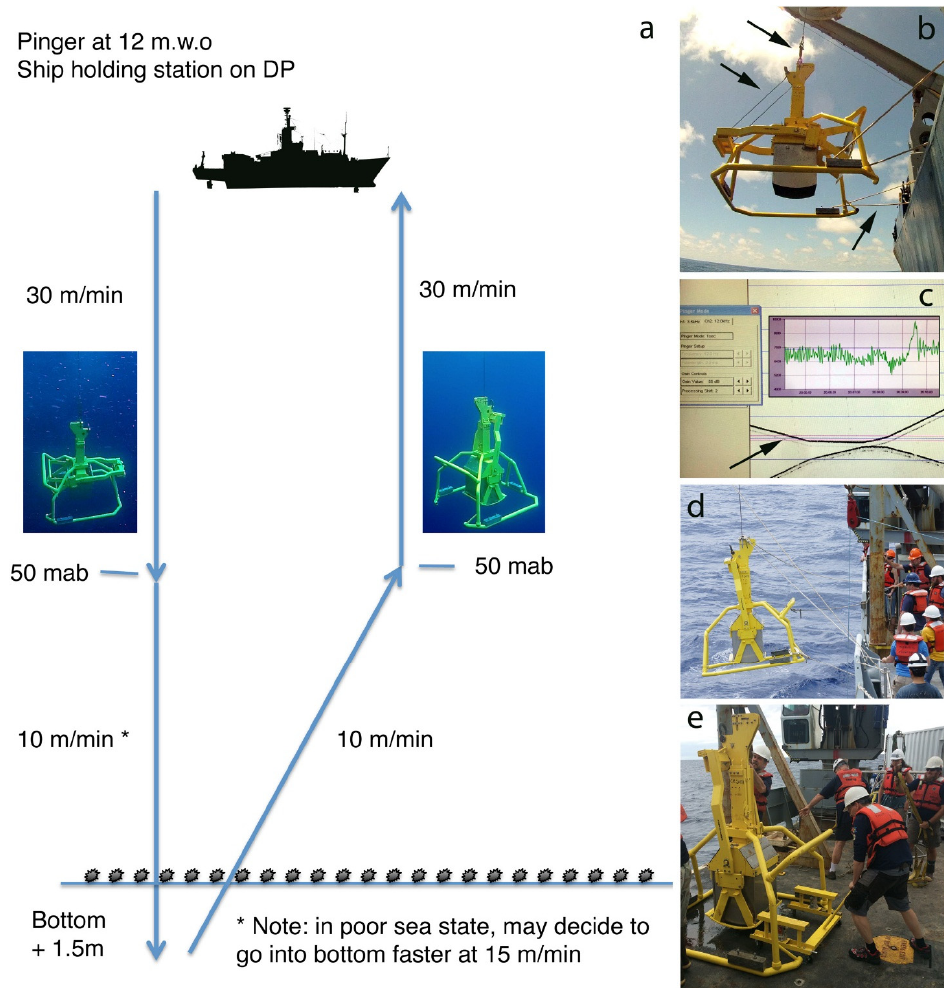
Figure Figure 8. Typical Ocean Instruments BX-S50 MK-III Spade Core (BC) deployment protocol. ( a ) Graphical depiction of the deployment in central Pacific abyssal depths with wire speeds indicated in m/min (mab = metres above bottom). An additional 1.5 m of wire is paid out after BC touchdown. ( b ) BC being deployed over the starboad a-frame on the RV Melville , 3-tonne swivel (top arrow), lifting cable (middle arrow) and tag lines (bottom) arrowed. ( c ) Echosounder trace from Kongsberg EA600 software during actual seafloor